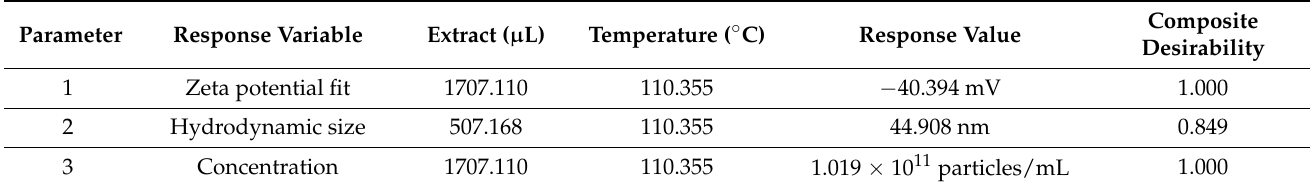
Table 3. Optimal condition prediction based on response surface